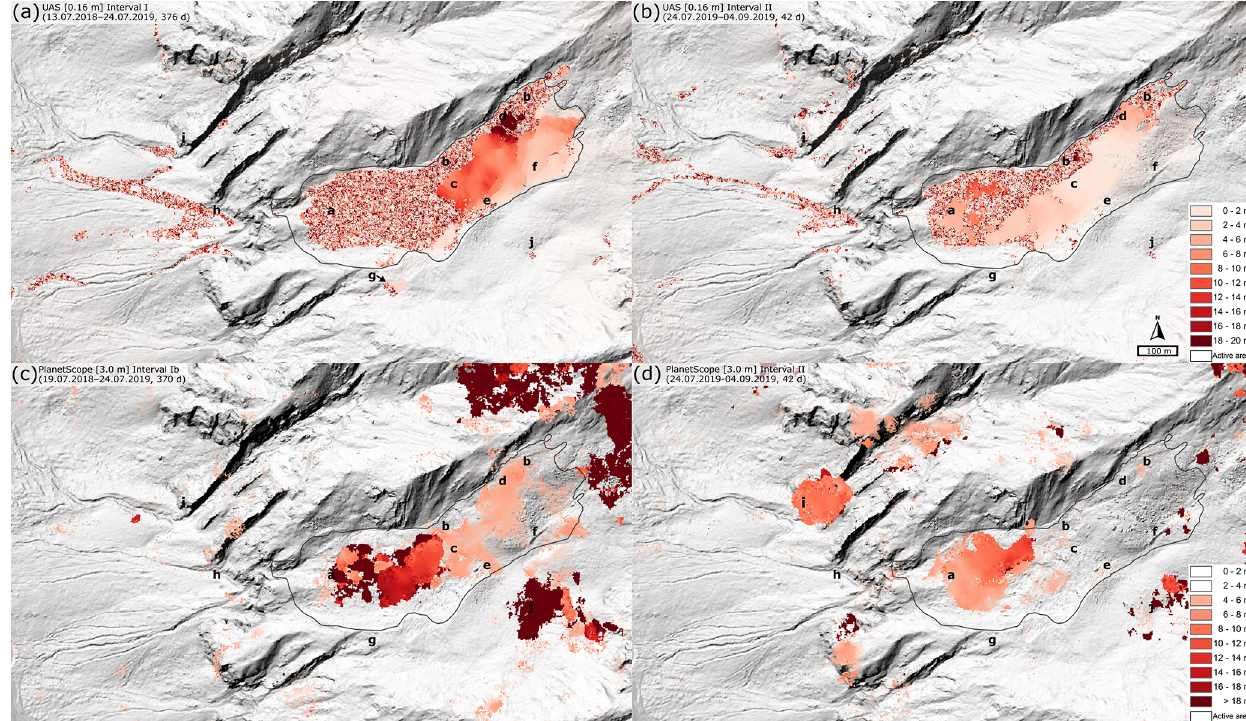
Figure 5. Results of DIC total displacement of orthoimages for the UAS for (a) and (b) at a 0.16m resolution and PlanetScope (c) and (d) at a 3m resolution. Time intervals for UAS image pair (a) I (13 July 2018–24 July 2019, 376d) and (b) II (24 July–4 September 2019, 42d) and for PlanetScope (c) Ib (19 July 2018–24 July 2019, 370 d) and (d) II (24 July–4 September 2019, 42d). Explanation of inconsistently tracked features (a) a and b and (b) b and the northwestern landslide head are described in Sect. 5.2. The solid black line represents the boundary of the active landslide based on field mapping. Background: hillshade of lidar DEM, 1m resolution (©